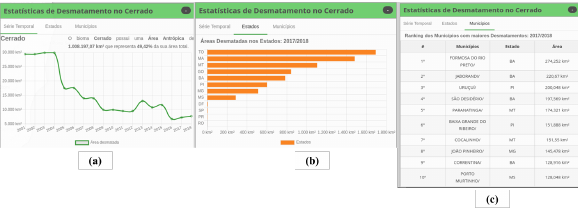
Figure 7. PRODES-Cerrado data over the years (a), ranked by state (b) and municipalities